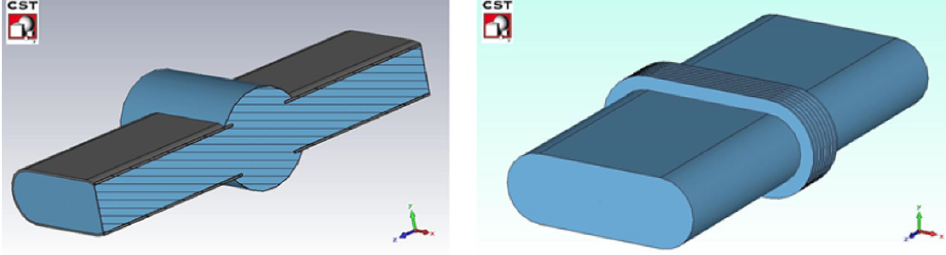
FIG. 8. 3D model of a PS vacuum pump used for CST Particle Studio simulations (left); 3D model of a PS bellow used for CST Particle Studio simulations (right).